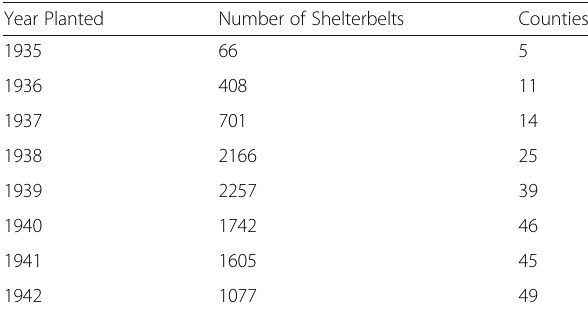
Table 3 Nebraska historic shelterbelt plantings summary table quantifying total plantings per year in each participating